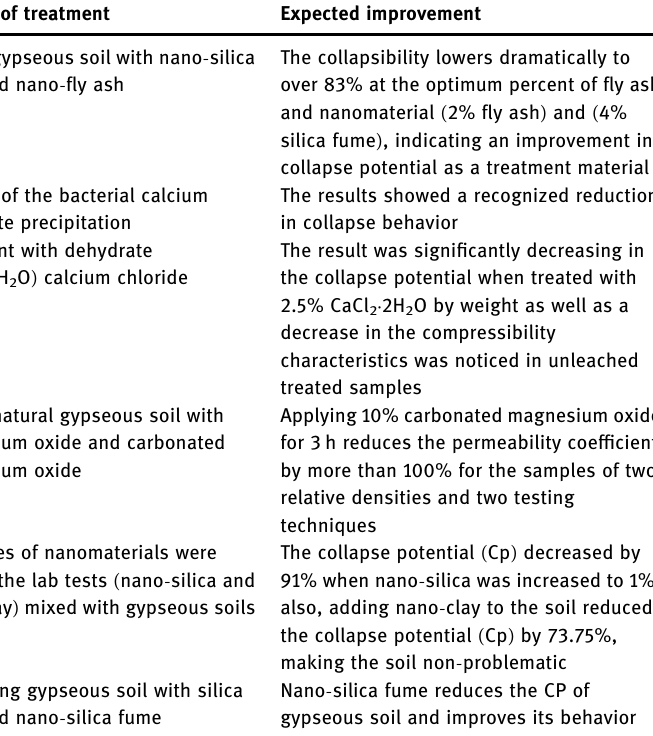
Table 2: Previous studies on treatment methods for improving gypseous soils